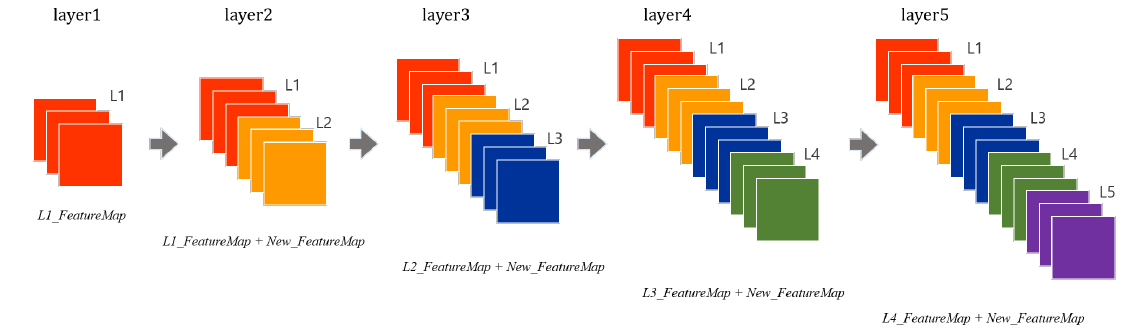
Figure 3. A five-layer dense block in DenseNet.